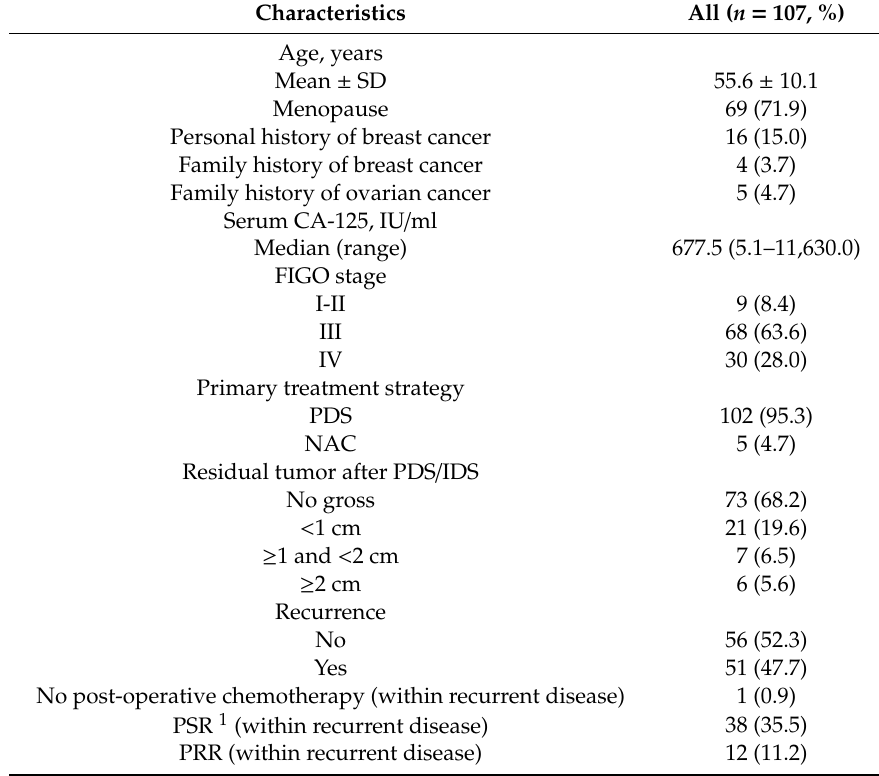
Table 1. Clinicopathologic characteristics of the patients who underwent prognostic validation.